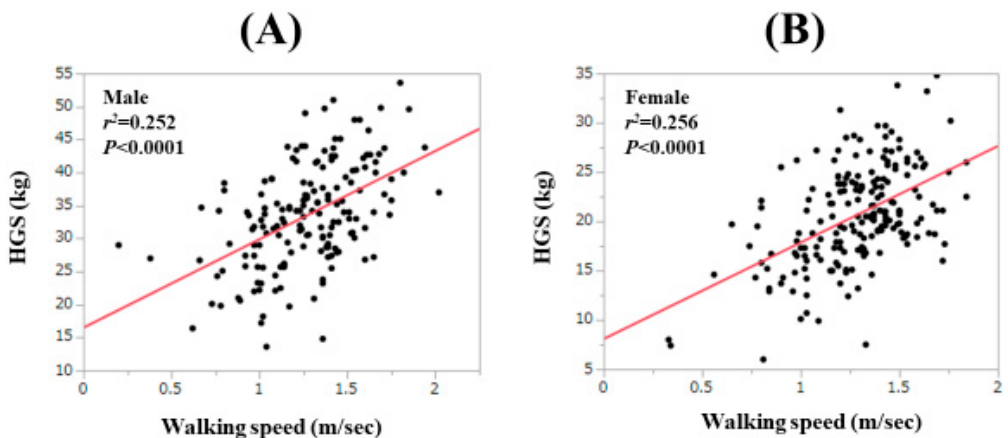
Figure 3. Correlation between the WS value and the handgrip strength value in males ( A ) and in females ( B ).